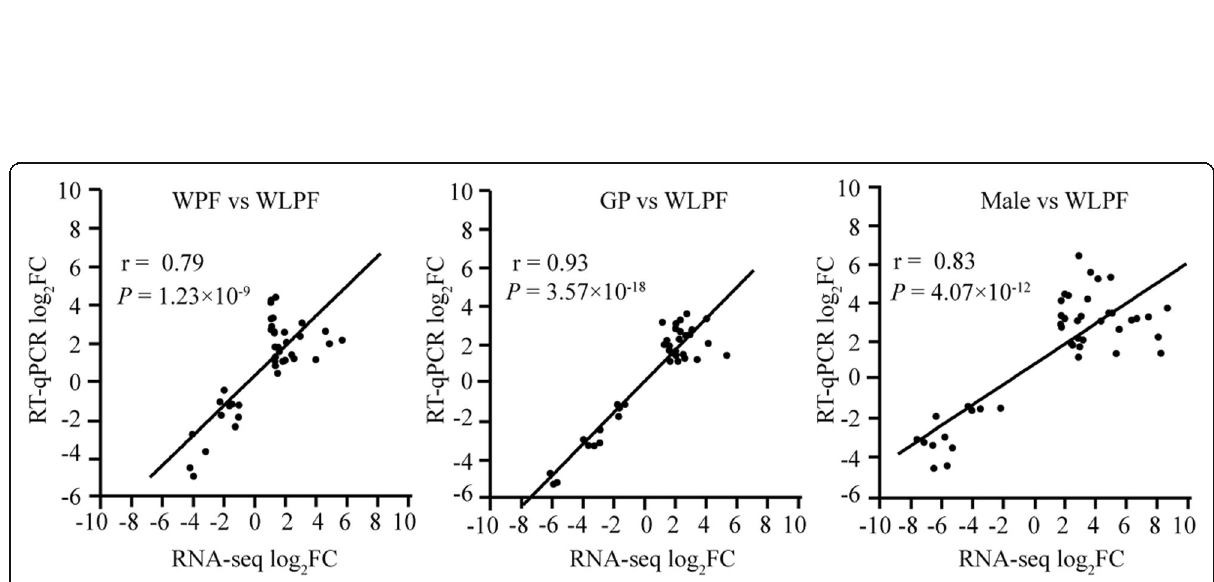
Fig. 6 RT-qPCR validation of RNA-Seq results. Validation of gene expression levels (44 selected genes) through the Pearson ’ s correlation ( r ) between FCs (log2 scale) observed in RT-qPCR and RNA-Seq results in the pairwise comparison between the winged and wingless morphs. a WPF versus WLPF; b GP versus WLPF; c male versus WLPF. FC, fold change, the relative expression of a gene in one morph to another